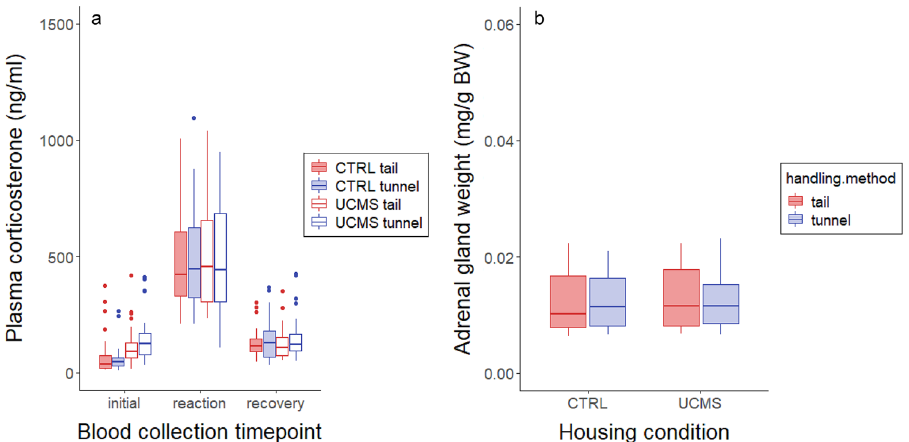
Figure 5. ( a ) Plasma corticosterone levels before 20 min restraint (initial value), immediately after restraint (reaction) and 70 min after restraint (recovery). UCMS housed mice had higher initial plasma corticosterone levels. There was no difference in corticosterone levels between tunnel and tail handled mice. ( b ) Adrenal gland weights relative to body weight did not differ between UCMS and CTRL mice nor between tail and tunnel handled mice.